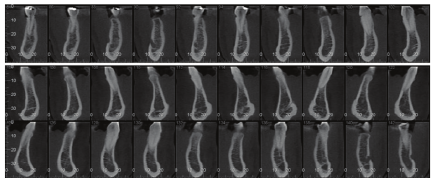
Figure 3: Model of parasagittal sections of the mandible as analyzed by the